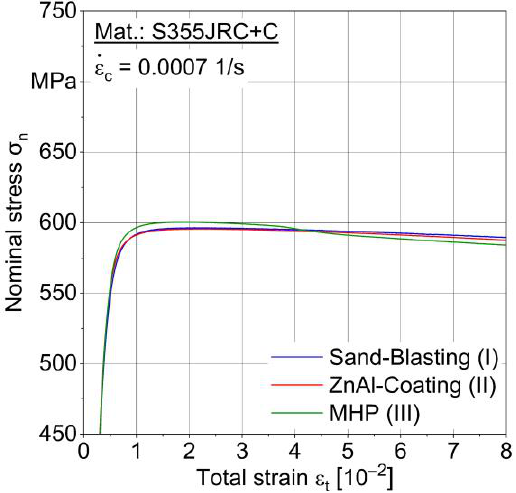
Figure 10. Stress-strain curves for sandblasted (I), ZnAl-coated (II) and machine hammer-peened